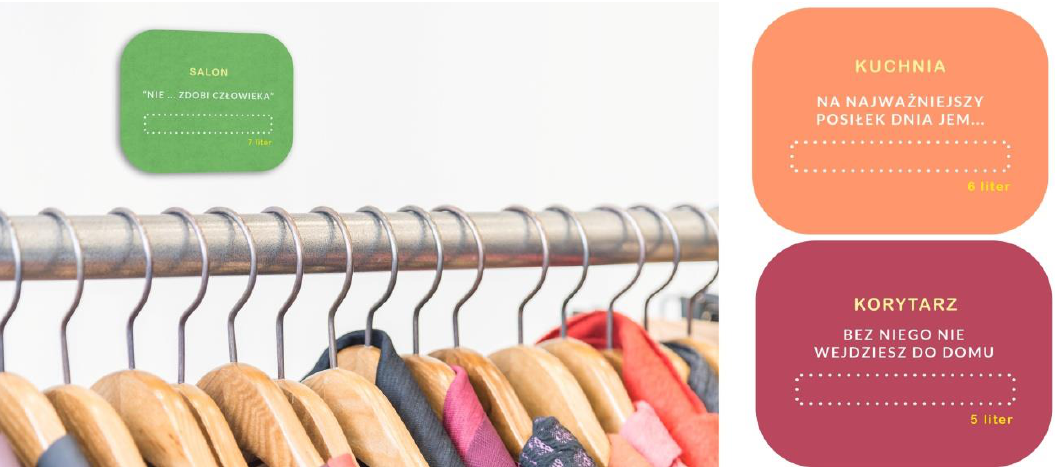
Figure 2. Design of stickers for an investor with dementia (picture: Students participating in the 8th edition of JAI).